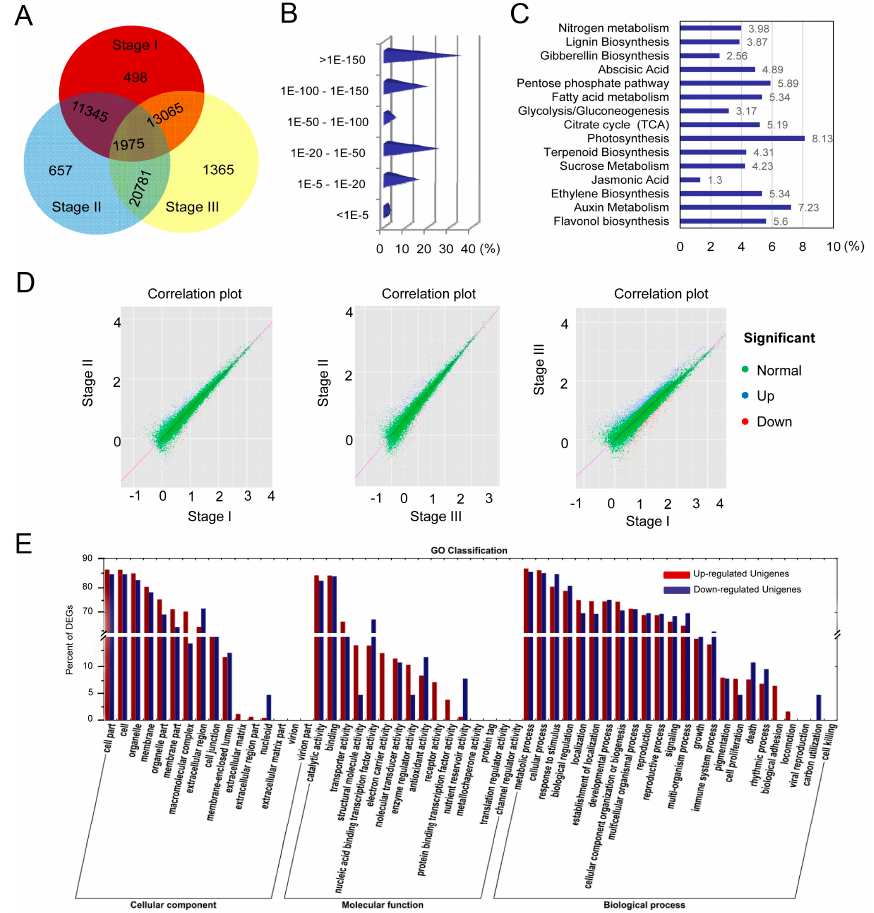
Figure 4. Homology alignments and expression analyses of DEGs. ( A ) Venn diagram of differentially expressed genes (DEGs) annotated by BlastX with an E- value threshold of 10 − 5 against protein databases; ( B ) E -value distribution of DEGs against nr database; ( C ) Overall 15-top categories involved in the signal pathways of biosynthesis and metabolism; ( D ) Distributions of correlation plots and expression characteristics of unigenes between both of stages; ( E ) GO classification of upregulated and downregulated